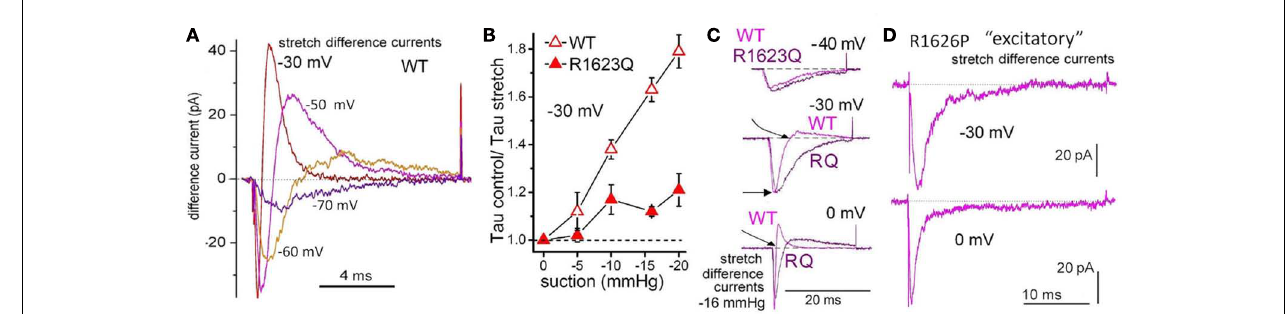
FIGURE 6 |Two LQT3 channels: impaired domain-4 voltage sensors, impaired mechanosensitivity. (A) Stretch difference currents forWT Nav1.5 channels (see Figure 3A for I Na before, during, after stretch; Morris and Juranka, 2007a). Because I Na is inward over the entire physiological range, and because Nav channels activate then rapidly inactivate, stretch difference currents for Nav channels are more complex than stretch difference currents for Kv channels ( Figure 2D ). For Nav rule is: downward = more I Na during stretch, upward = less I Na during stretch. Based on the Nav stretch difference currents at the voltages illustrated, imagine what would happen during an action potential: briefly near the start, stretch would increase I Na (downward) but quickly decreased I Na would prevail. If this happens in situ , when there is stretch, the faster turn off of I Na once an action potential was triggered would contribute in an anti-arrhythmic fashion to the overall mechano-electric feedback.The LQT3 mutations, R1623Q and R1626P, affect the Nav domain 4 voltage sensor, whose depolarization-induced repacking renders the inactivation rate (Tau − 1 ) voltage dependent by stabilizing the inactivation